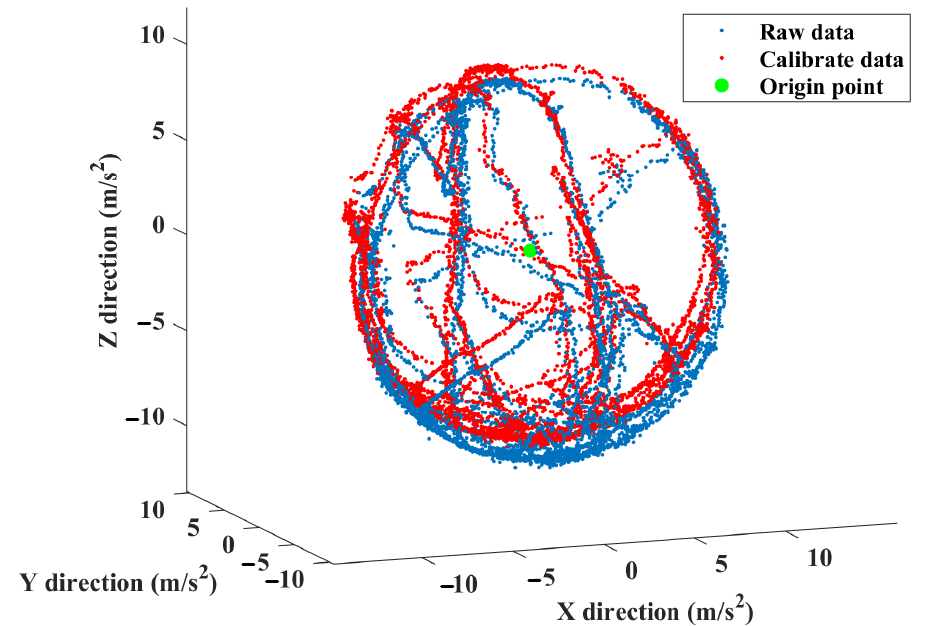
Figure 5. Ellipsoid fitting effect of accelerometer.